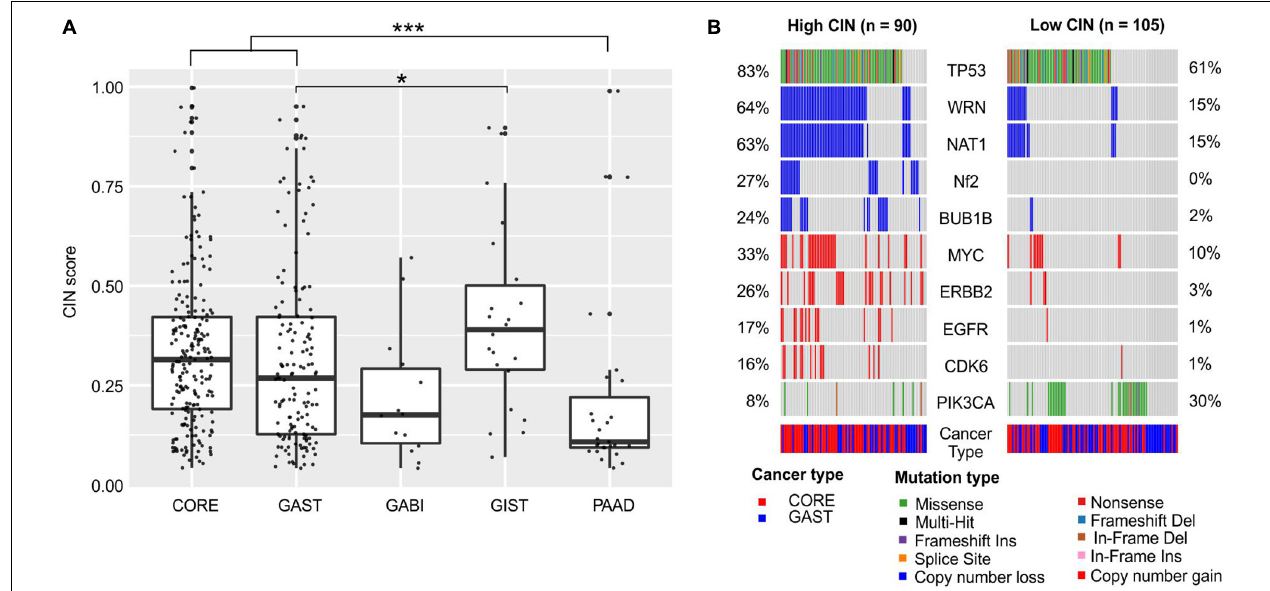
FIGURE 3 | Chromosome instability in each cancer and its association with gene alterations. (A) The distribution of CIN scores in each cancer. (B) Gene mutations and copy number changes that were significantly different between the high-CIN and low-CIN groups. For (A) , the one-way ANOVA on ranks test was used to compare all groups, and the Dunn’s test was used for post hoc analyses. * p < 0.05; *** p < 0.001. For (B) , pairwise comparisons were conducted between every two groups using the Fisher’s exact test. FDR was used for p -value